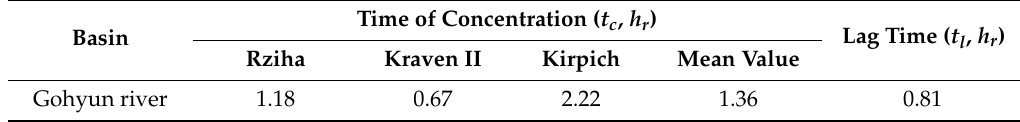
Table 2. t c and t l calculated in this